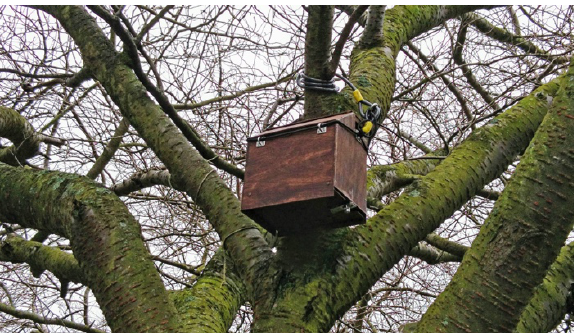
Figure 1. ACD box installed in tree